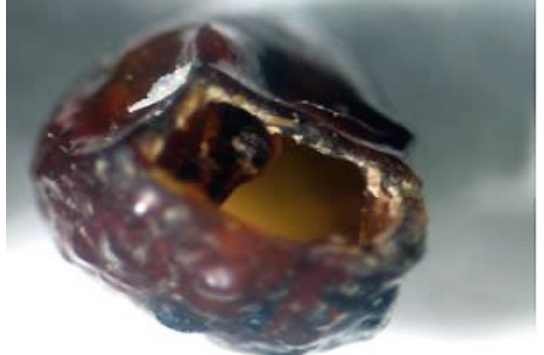
Figure 2: The view of an open telson (by Ozkan O. et al . J. Venom. Anim. Toxins incl. Trop. Dis ., 2006, 12,